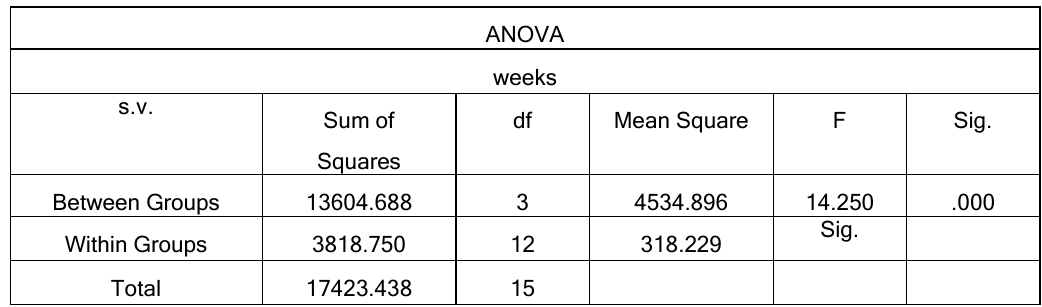
Table (3): show analysis of variance for the effect of time factor on the complete formation of bone for the four different